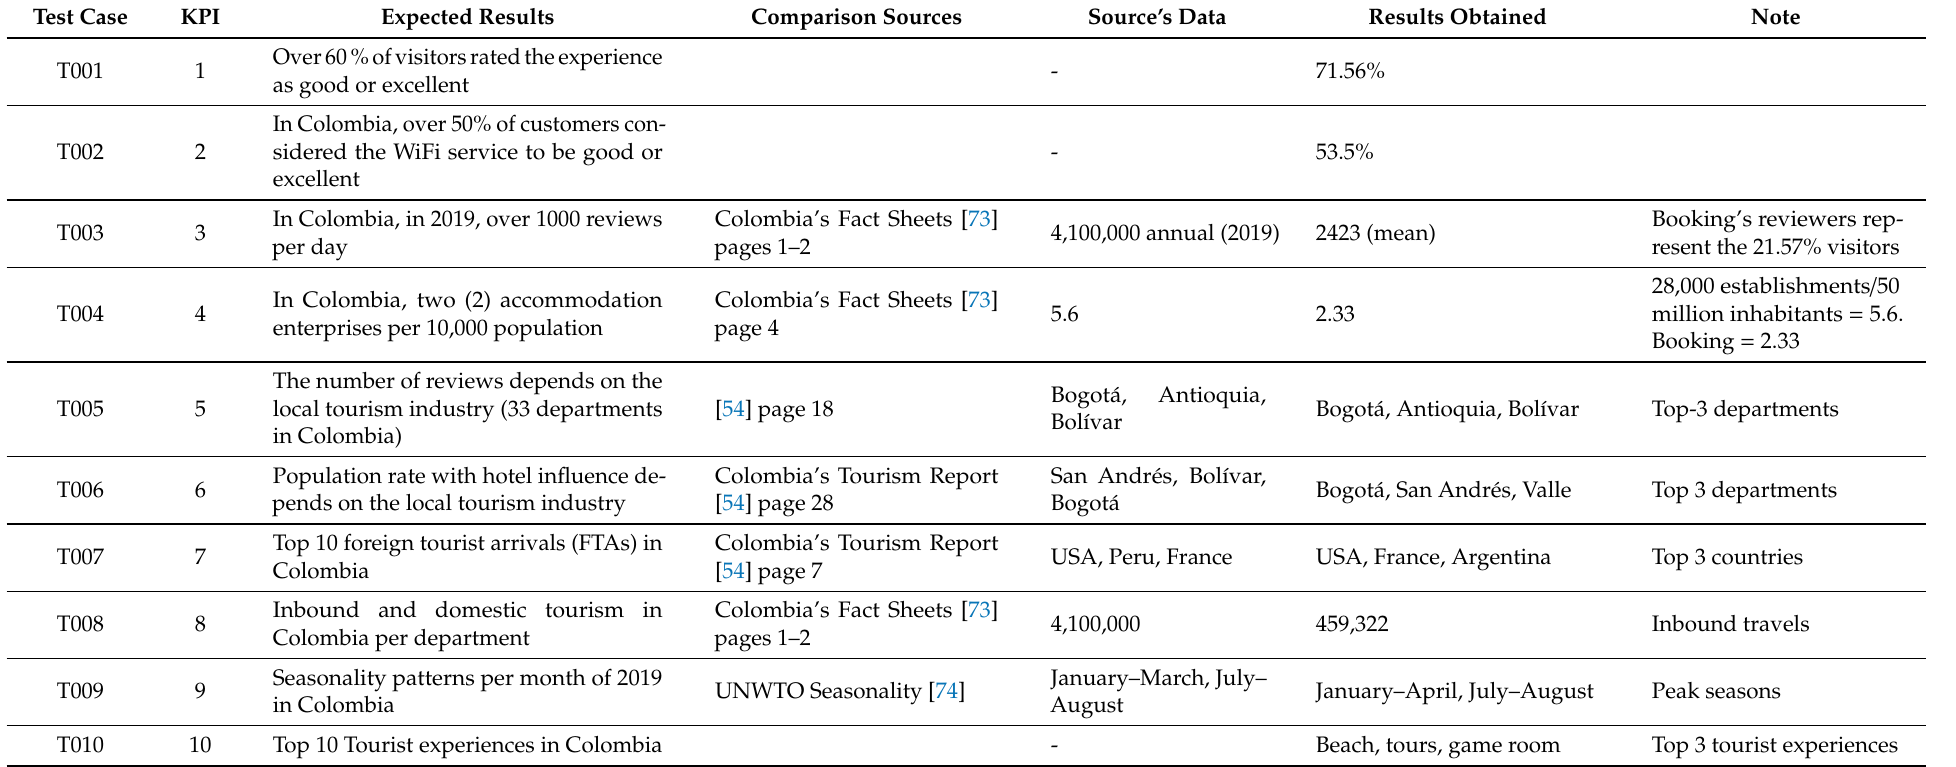
Table 11. Expected